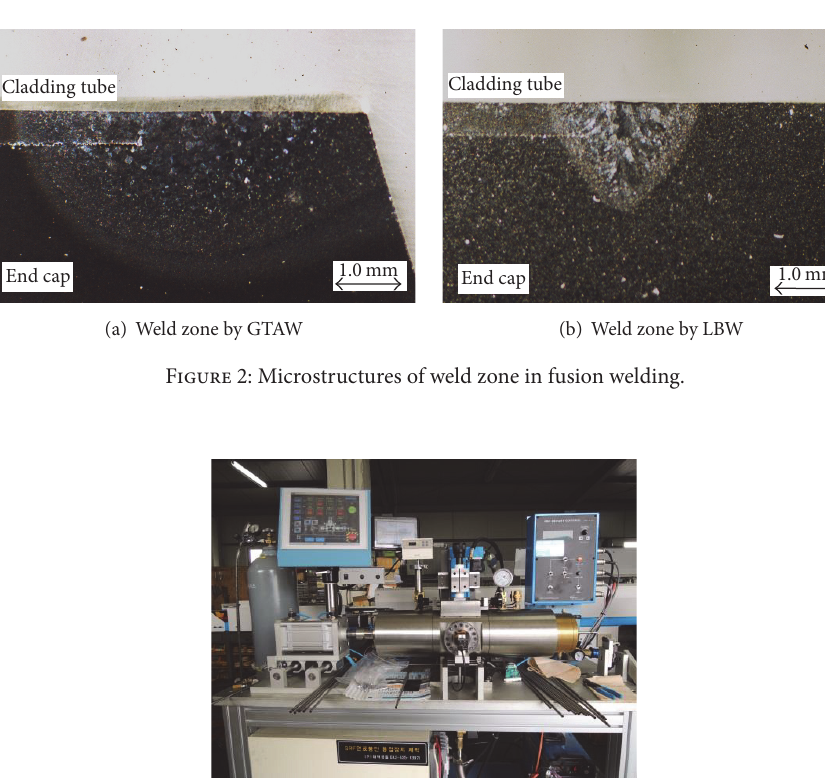
Figure 3: Photograph of the GTAW system for end plug